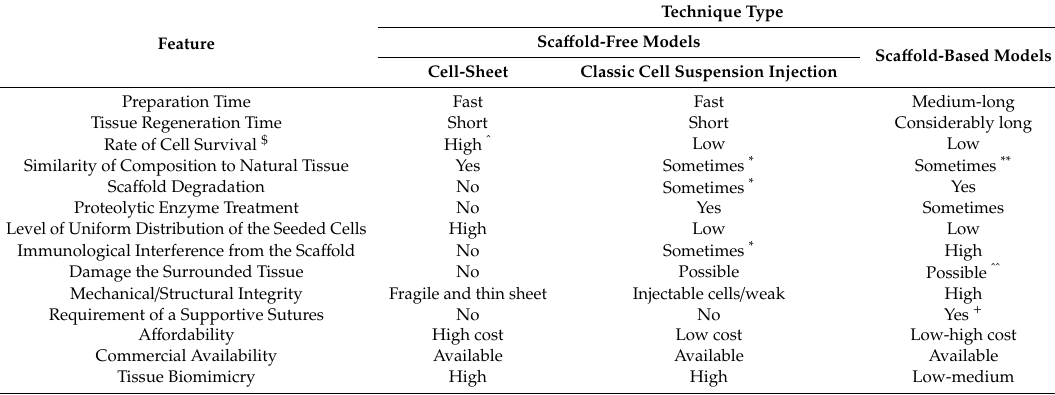
Table 4. A comparison between sca ff old-based and sca ff old-free strategies in tissue